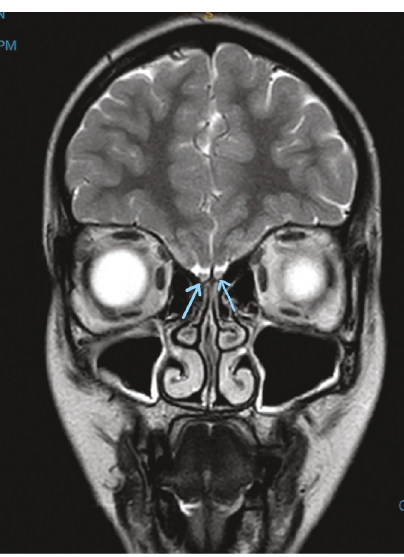
Figure 3: Coronal view showing the presence of the olfactory bulb bilaterally (blue arrow).